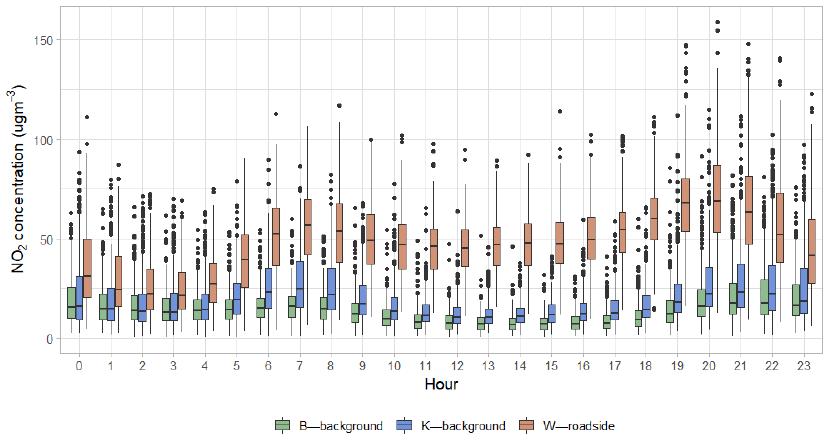
Figure 3. Nitrogen dioxide hourly variability from 10 March to 30 May 2016–2019.